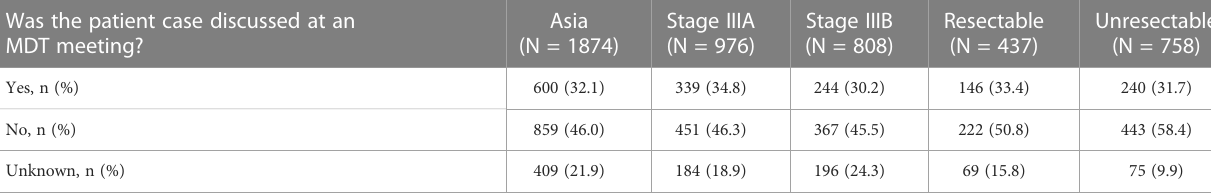
TABLE 1 Outcome discussed at the multidisciplinary team meeting in